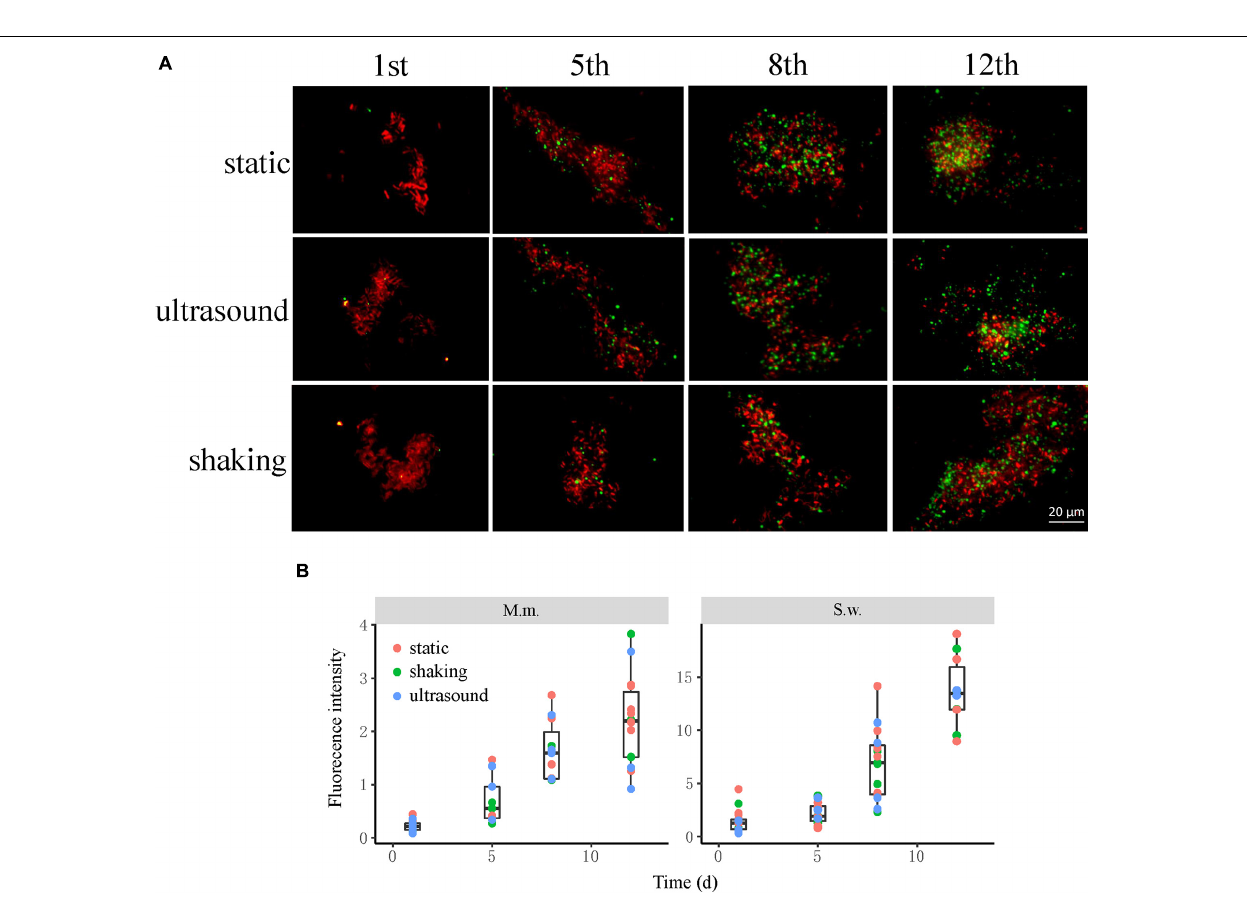
Frontiers in Microbiology |